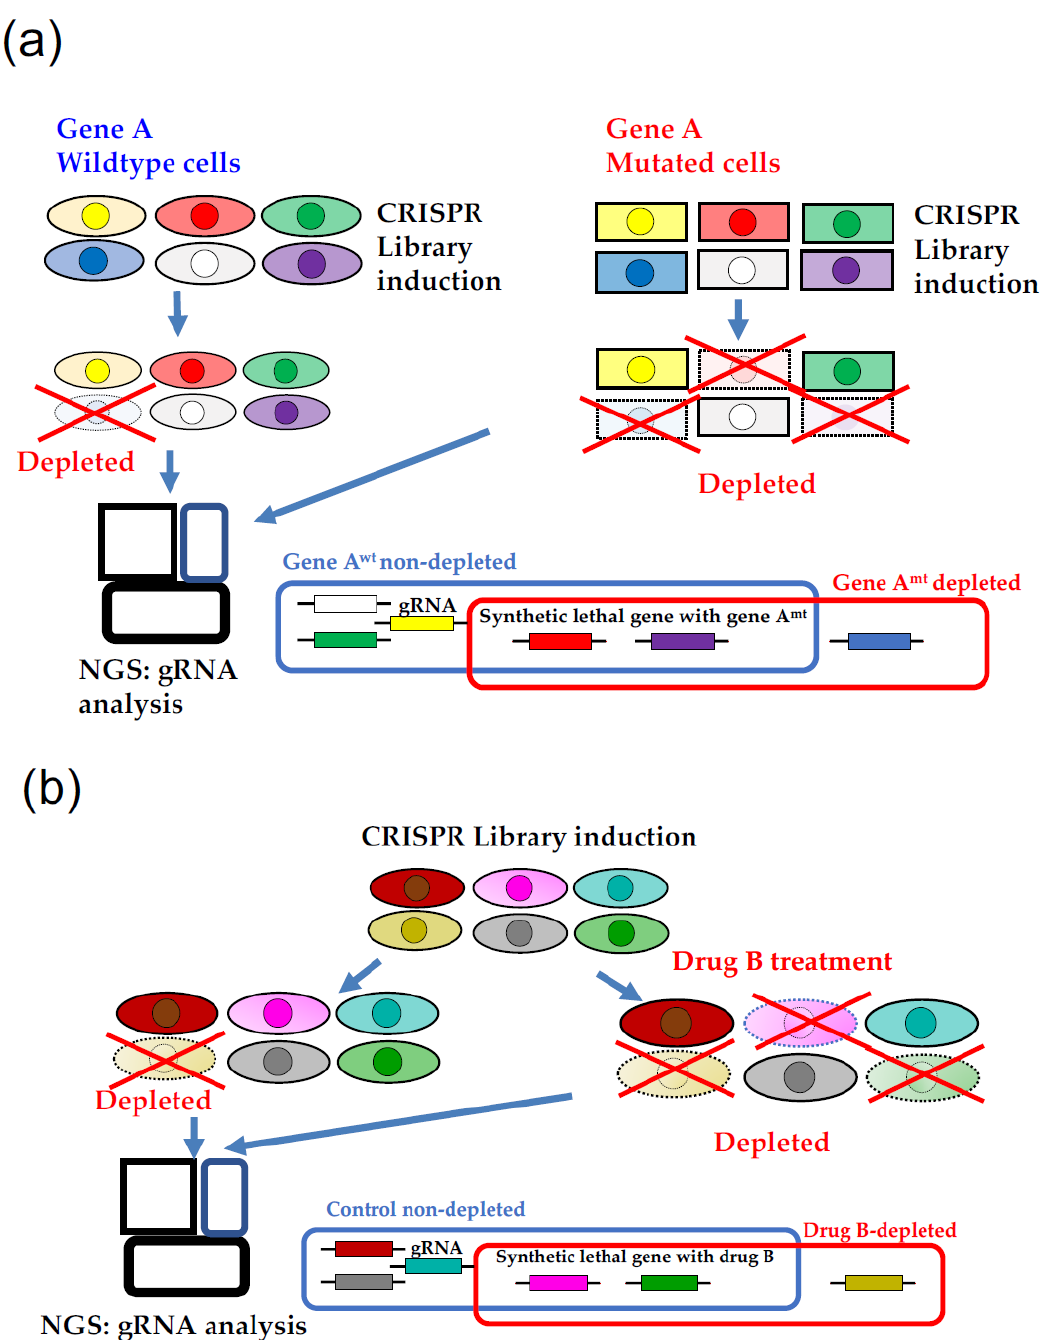
Figure 1. Synthetic lethal research using a CRISPR KO library. ( a ) Synthetic lethal gene detection with gene A using CRISPR (KO) library. Gene A mutated cells (square cells) containing red and purple gRNA induce cell death alongside the culture. Red and purple gRNA are synthetic lethal genes with a gene A mutation. While blue gRNA, which induced cell death in gene A wild type and gene A-mutated cells, is an essential gene for both cells and not a synthetic lethal gene. ( b ) Synthetic lethal gene detection with drug B using CRISPR KO library. Cells containing pink and green gRNA induce